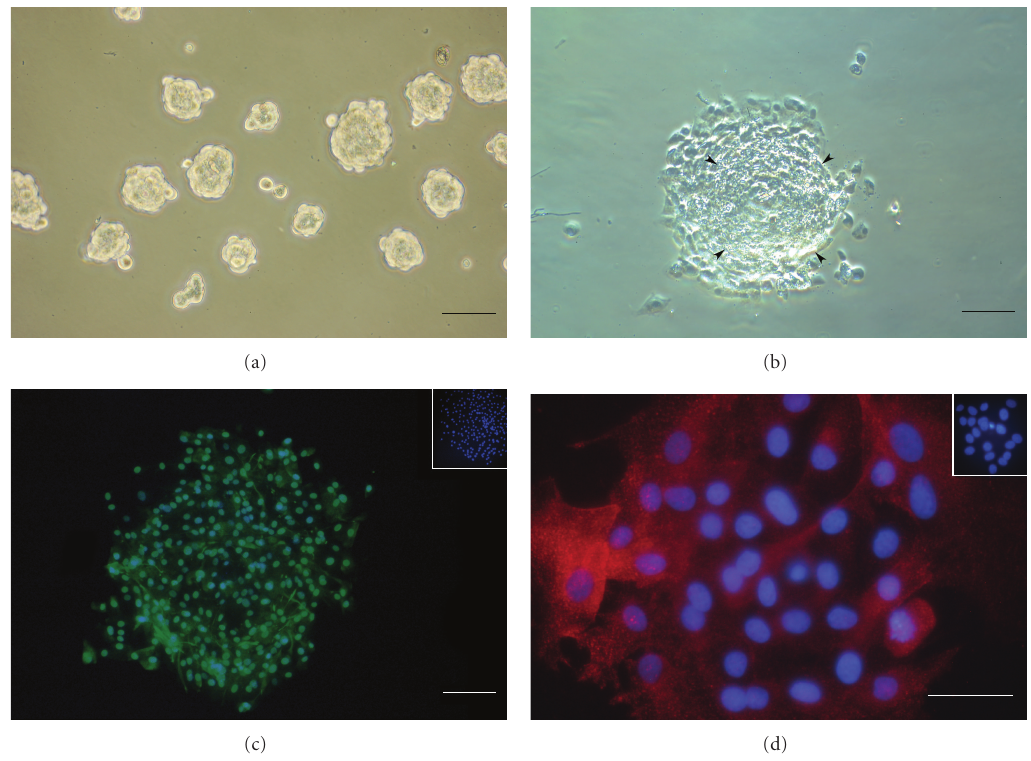
Figure 4: Sphere culture of bovine peripheral corneal endothelial cells. (a) Floating spheres on day 7 in defined serum-free media. Aggregation and development of dark cores can occur when spheres are left over the optimal culturing period of 5–7 days. (b) Cells migrating from an attached sphere on adherent substrate. The arrowheads show the contour of the sphere. (c) Nestin (green: undi ff erentiated cell marker) and (d) β -III tubulin (red: neuronal marker) staining were detected in the cells that migrated from the primary spheres. Nuclei were counterstained with DAPI (blue). Insets are negative controls with nonimmunized IgG. (a–c) Scale bar = 100 μ m; (d) Scale bar = 50 μ m.